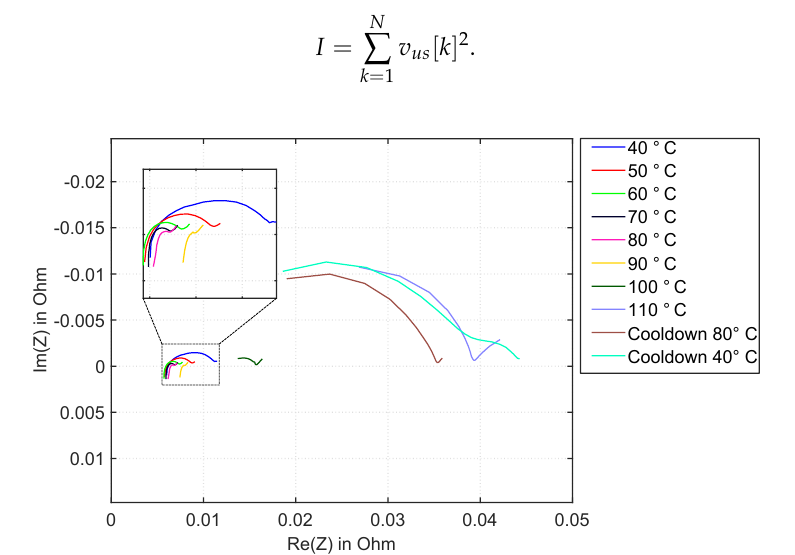
Figure 14. Experiment HT3: Nyquist plot of the complex impedance of a Kokam 3.3Ah cell in the range from 1Hz to 6kHz at different temperatures, including cool-down.